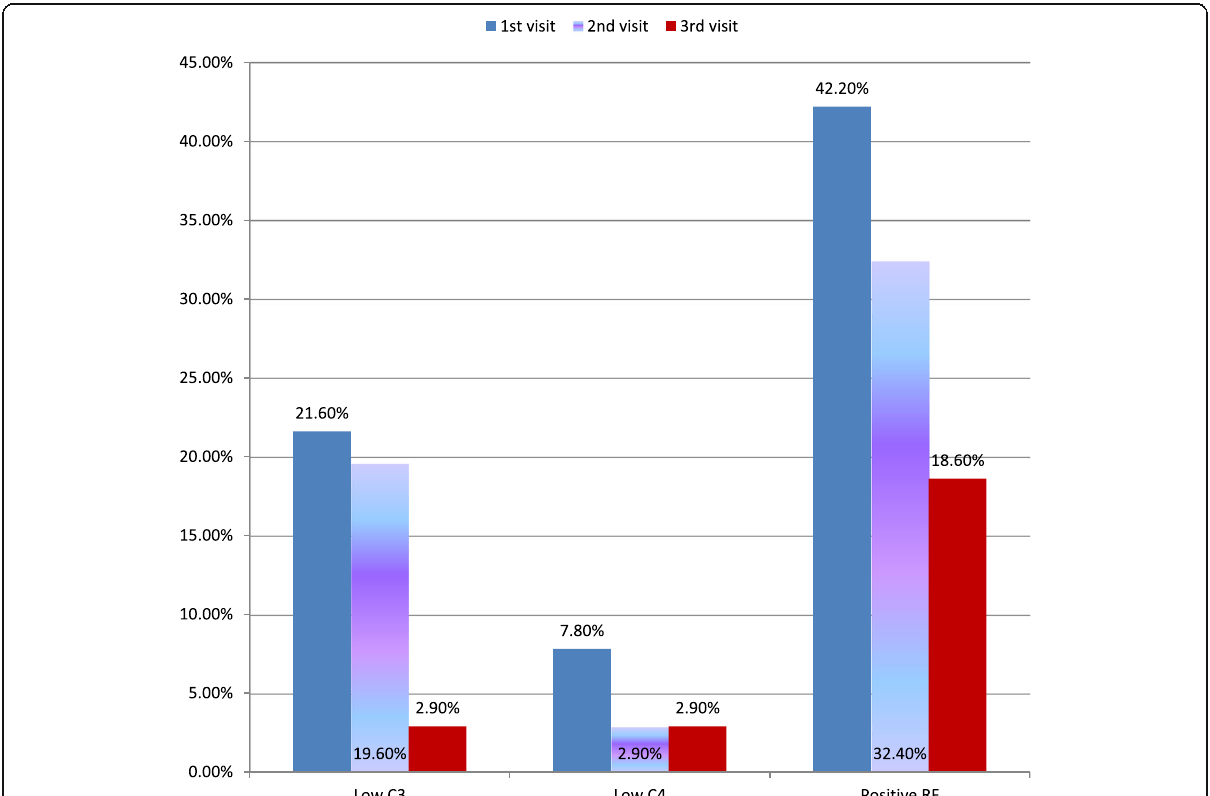
Fig. 1 percentage of patients with low C3 (21.6%, 19.6%, 2.9%), low C4 (7.8%, 2.9%, 2.9%), and positive RF (42.2%, 32.4%, 18.6%) decreased significantly across the three